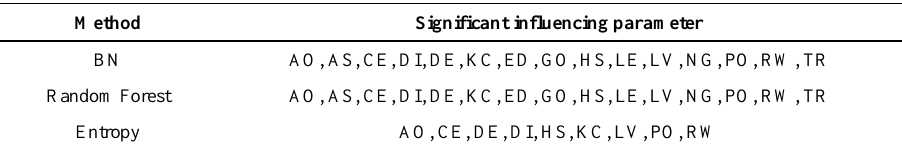
Table 3. The set of significant influencing parameters on PE in directed